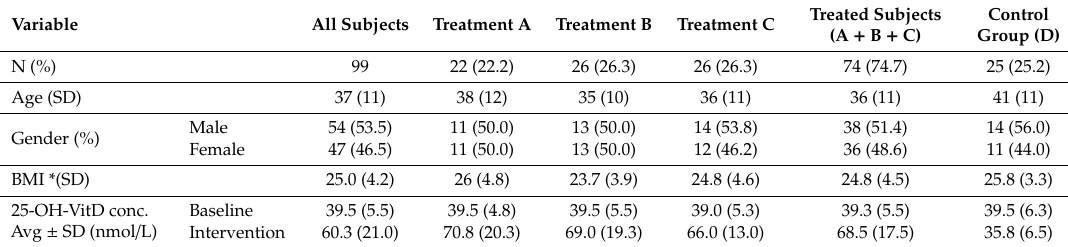
Figure 2. Histogram presenting distribution of wintertime serum 25-OH-Vitamin D concentrations in subjects included to screening (N = 238, February). Table 2. Descriptive statistics for subjects that completed the study (N = 99).